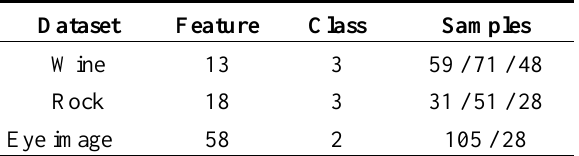
Table 9 . Summary of the benchmark datasets [16].